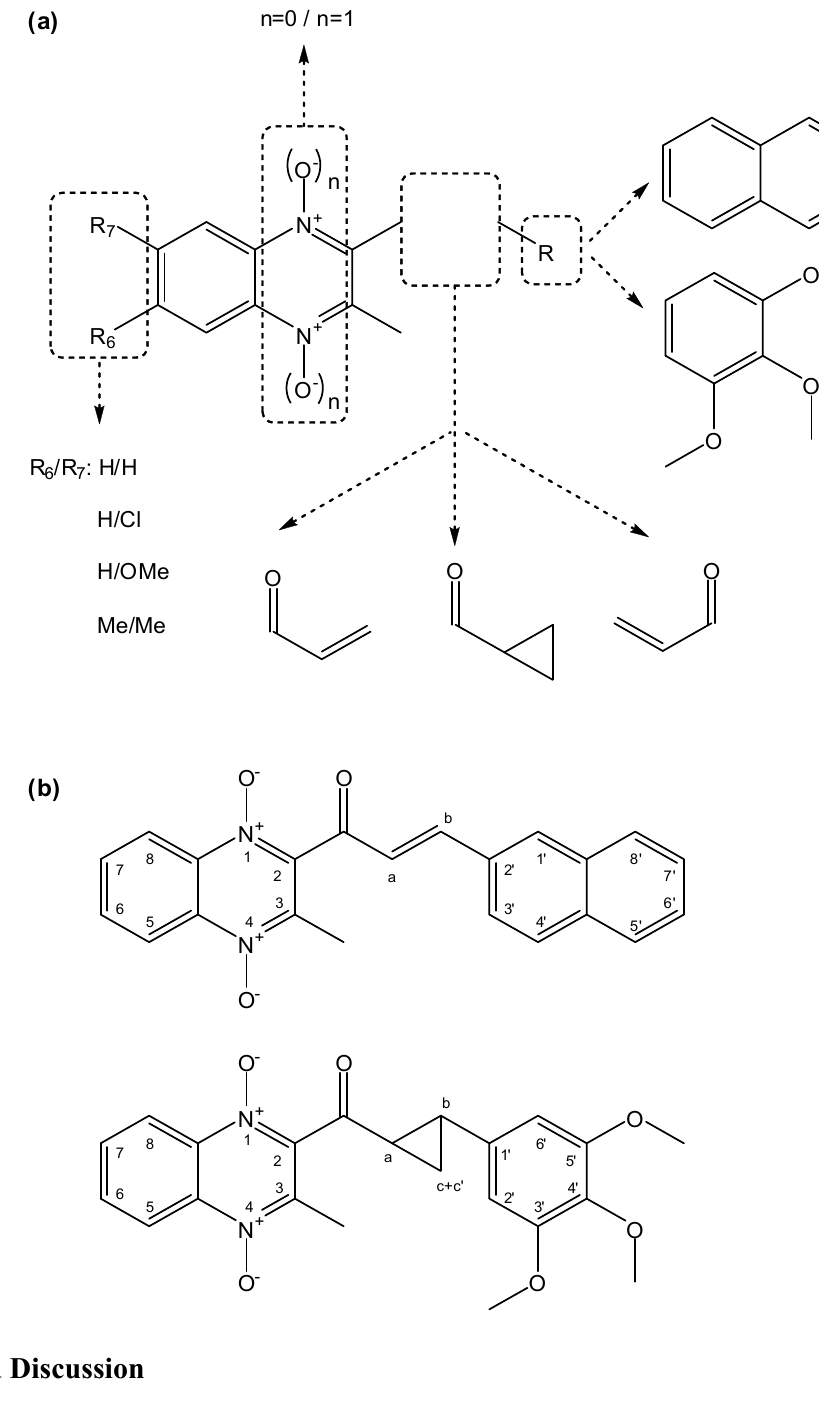
Figure 1. ( a ) Design of quinoxaline derivatives as potential antimalarial drugs. ( b ) Examples of two numbered compounds obtained in this